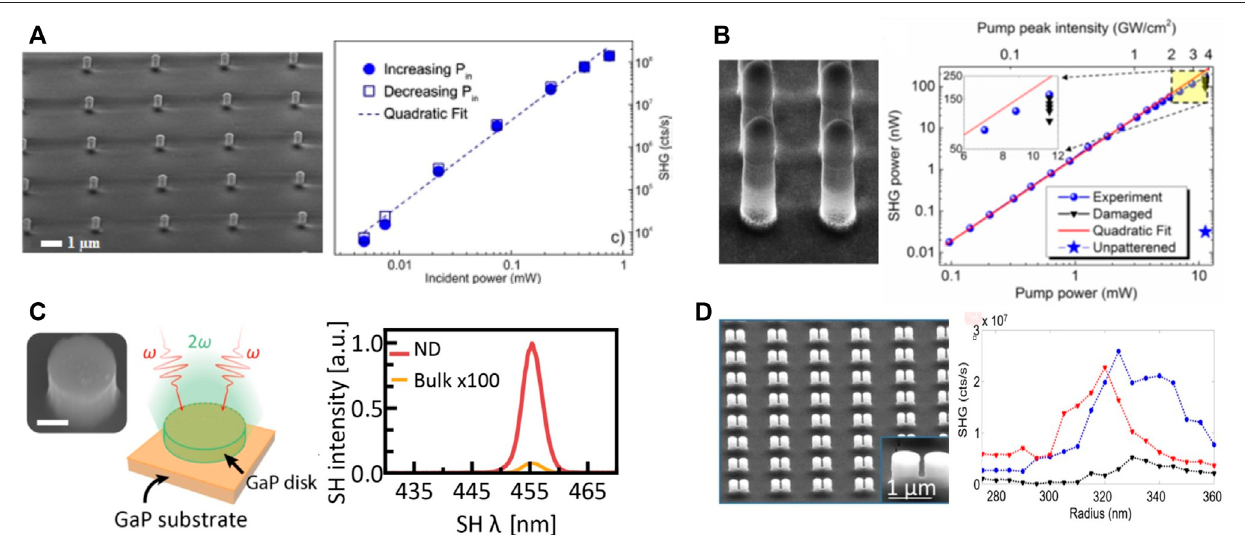
FIGURE 5 | Nonlinear SHG process in dielectric nanostructures with different materials and geometries. (A) SEM picture of monolithic AlGaAs-on-AlOx nanoantennas and the SHG ef fi ciency on nanoantennas (Gili et al., 2016). (B) SEM picture of GaAs dielectric metasurface and the quadratic relationship between the average pump and SHG powers at low pump intensities. Inset is the deviation from the quadratic relationship at higher pump intensities due to the damage of GaAs resonators(Liuetal.,2016). (C) SEMpictureofGaPnanodisksandtheSHspectraofthenanodisksandbulkGaPsubstrateforanexcitationwavelengthof910 nm (Cambiasso et al., 2017). (D) SEM images of AlGaAs-on-AlOx nanodimers and the measured SHG for the dimer structure as a function of radius for two pump polarizations: alongthe x axis(bluecurve)andalongthe y axis(redcurve), andtheblacklinerepresents themeasured SHG forthesingle-cylinderstructure (Roccoet al.,